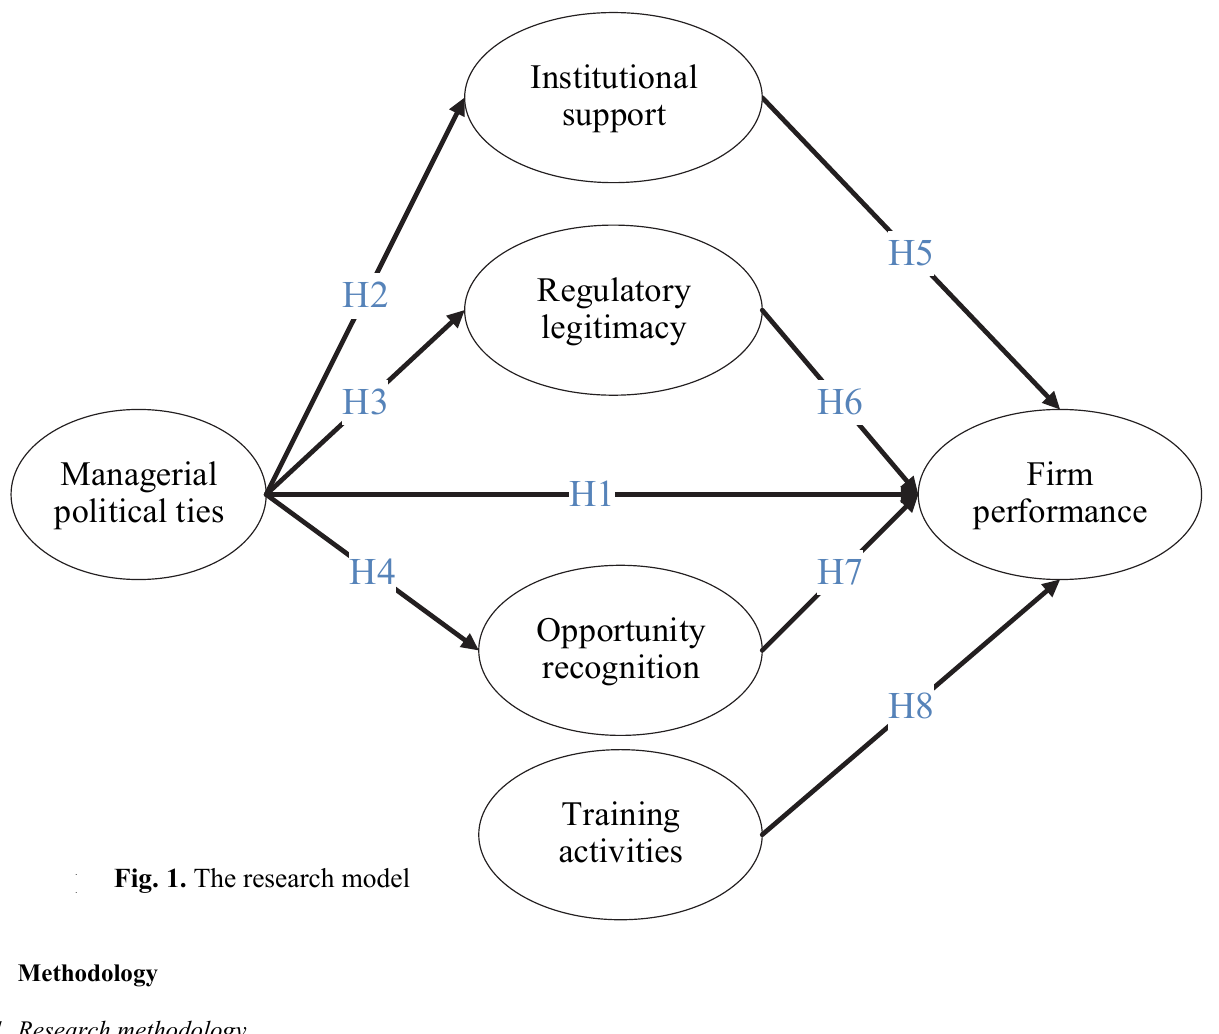
Figure 1. The research